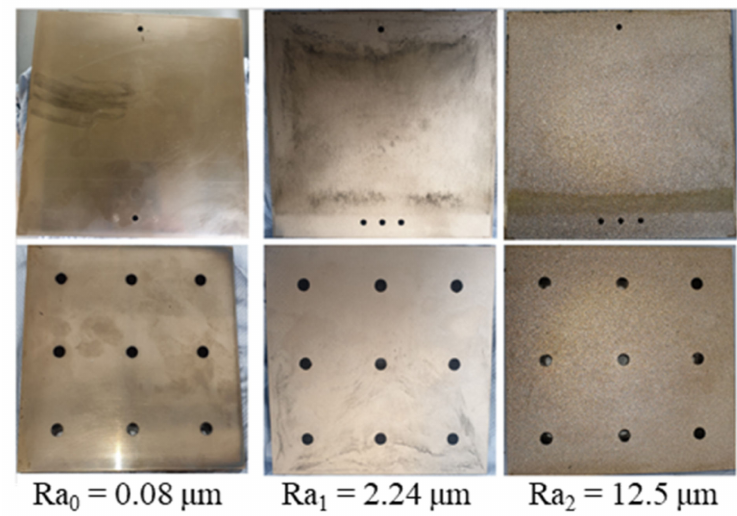
Figure 3. The cavity inserts with different surface